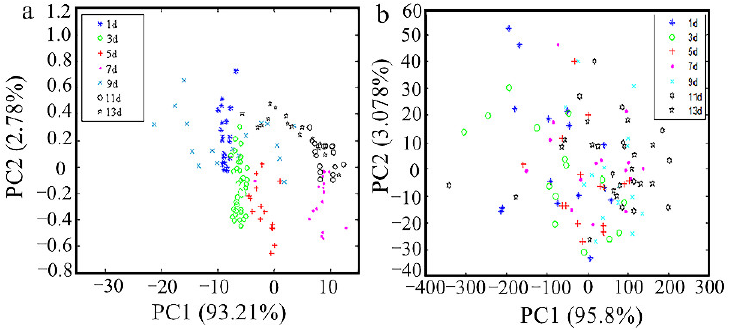
Figure 3. Two-dimensional (2D) space of egg samples represented by PC1 and PC2 stored at temperatures of 4 °C ( a ) and 25 °C ( b ).